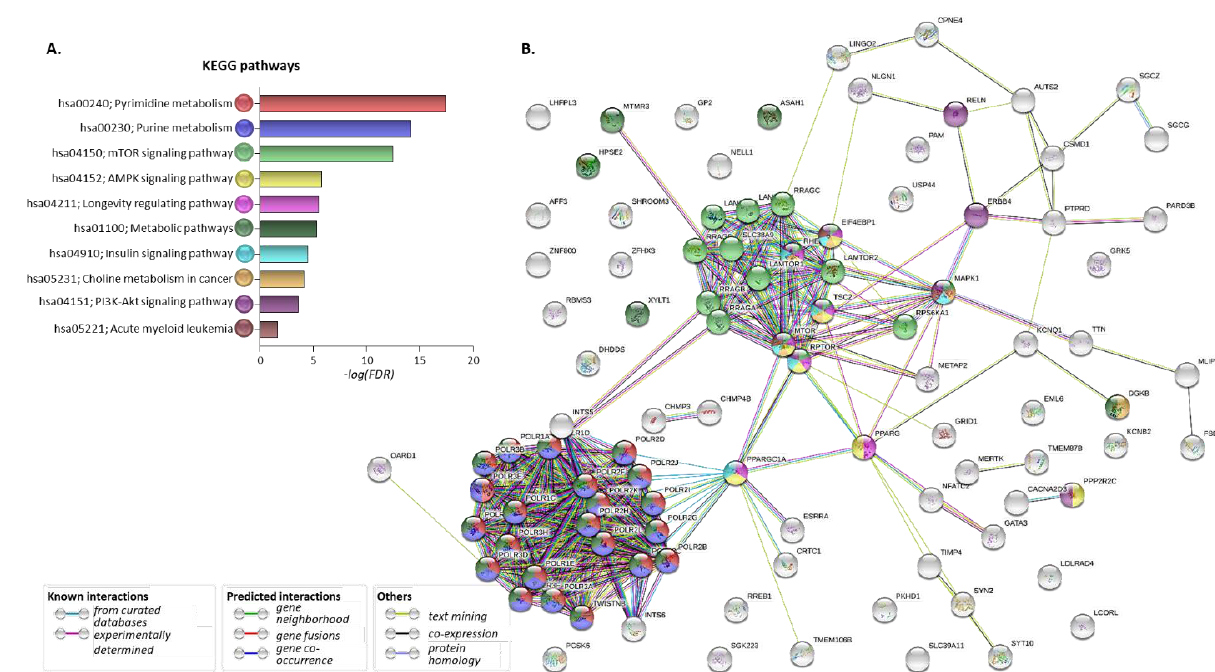
Figure 4. Pathways and protein–protein interactions regulated by the common AML/T2D-related genes. ( A ). Pathways enriched upon gene set analysis of 86 AML/T2D common susceptibility genes plus the seven eGenes affected by the five common AML/T2D susceptibility genes and their proxies, using KEGG database. ( B ). Protein–protein interaction (PPI) network developed upon processing the set in the STRING database. Different genes/proteins involved in different (one or more) pathways are designated by the differently colored nodes. Edges represent protein–protein associations—either known interactions, predicted interactions or other associations. Table 6. Selected pathways significantly regulated by the set of 86 AML/T2D susceptibility genes plus seven eGenes affected by the five common AML/T2D susceptibility genes and their proxies, as analyzed upon processing in the STRING and KEGG databases [25,26]. Pathway IDs and description, number of susceptibility genes involved, number of background genes, their names as well as statistics (strength, FDR and log 10 FDR) for each pathway are